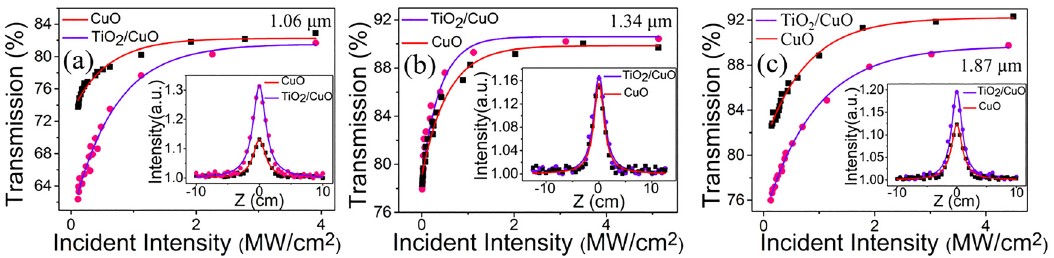
Figure4: Thenonlineartransmissioncurvesandsaturableabsorptioncurves(theinsets)ofcupricoxide(CuO)andTiO 2 /CuOnanocomposites